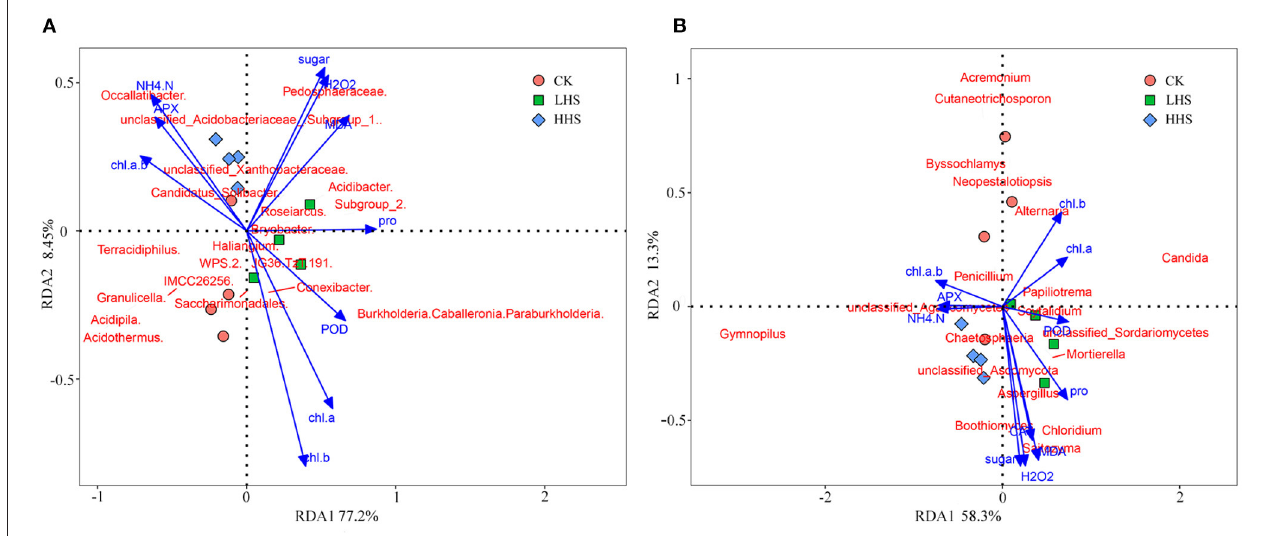
FIGURE 6 | Redundancy analysis (RDA) of physiological characteristics, soil physicochemical properties, and soil dominant microbial communities of Rhododendron simsii , (A) RDA of each indicator with the top 1% of OTU values for dominant bacteria; (B) RDA of each indicator with the top 1% of OTU values for fungi. CK, control (25 /20 ◦ C); LHS, light heat stress (35 /30 ◦ C); HHS, high heat stress (40 /35 ◦ C); MDA, Content of malondialdehyde; H 2 O 2 content of hydrogen peroxide; Pro content of proline; CAT, activity of catalase; POD, activity of peroxidase; APX, activity of ascorbate peroxidase; Chl a , content of chlorophyll a ; Chl b content of chlorophyll b ; Chl a + b , content of chlo-rophyll a + b ; NH + 4 − N, Content of soil